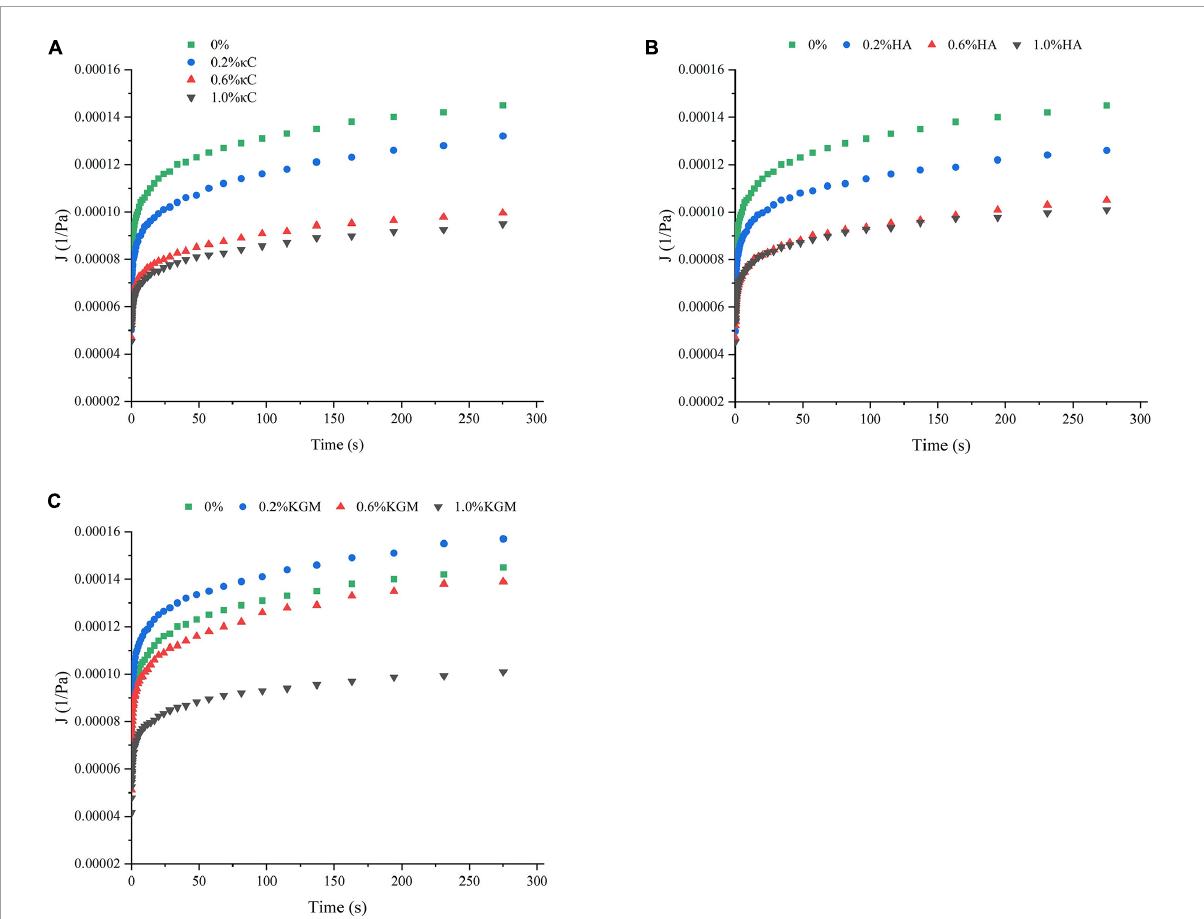
FIGURE5 Compliance curve of emulsion gels containing different polysaccharides: (A) κ C, (B) HA, and (C) KGM. κ C, κ -carrageenan; HA, high-acyl gellan; KGM, konjac glucomannanon.